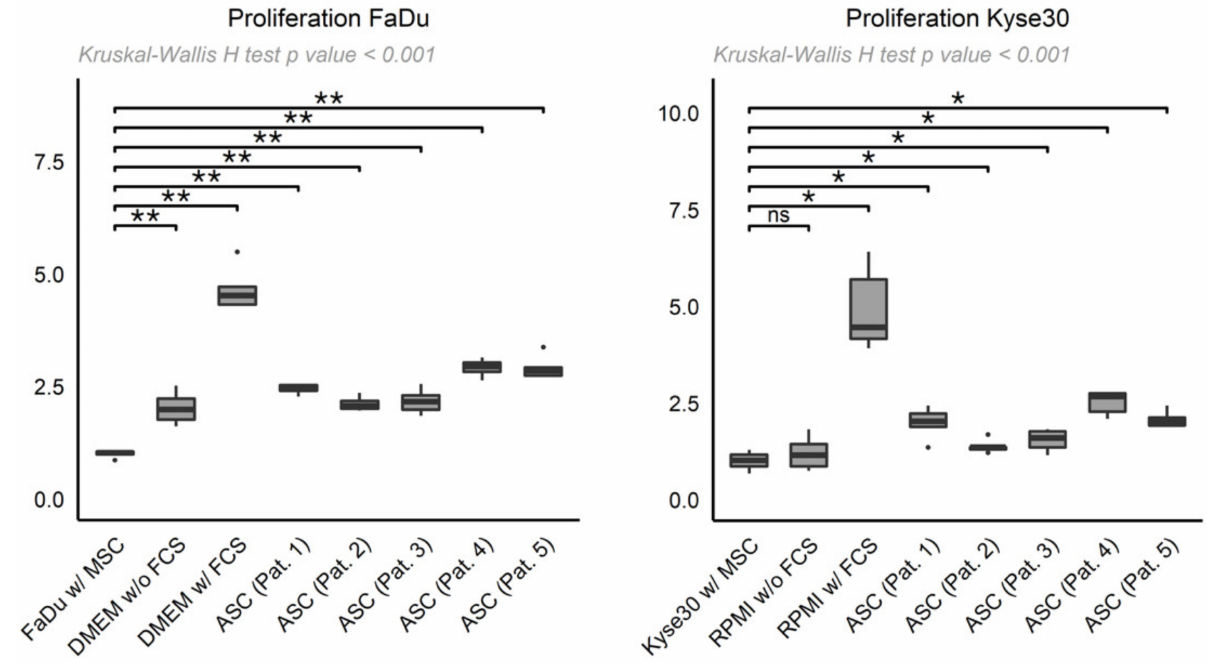
Figure 2. Box-whisker plots depicting normalized proliferation of FaDu ( left ) and Kyse30 cells ( right ), cultured with ASC-derived supernatants from patients 1–5 (“ASC (Pat. 1–5)”) or supernatant from FaDu/Kyse30 with MSCM 2 (“FaDu w/ MSC”, “Kyse30 w/ MSC”), DMEM/RPMI without FCS (“DMEM w/o FCS”, “RPMI w/o FCS”), and DMEM/RPMI with FCS (“DMEM w/ FCS”, “RPMI w/ FCS”) as controls. Shown are mean ± SD from n = 3 independent experiments. Statistical test: Kruskal–Wallis H test, p -values * < 0.05, ** <